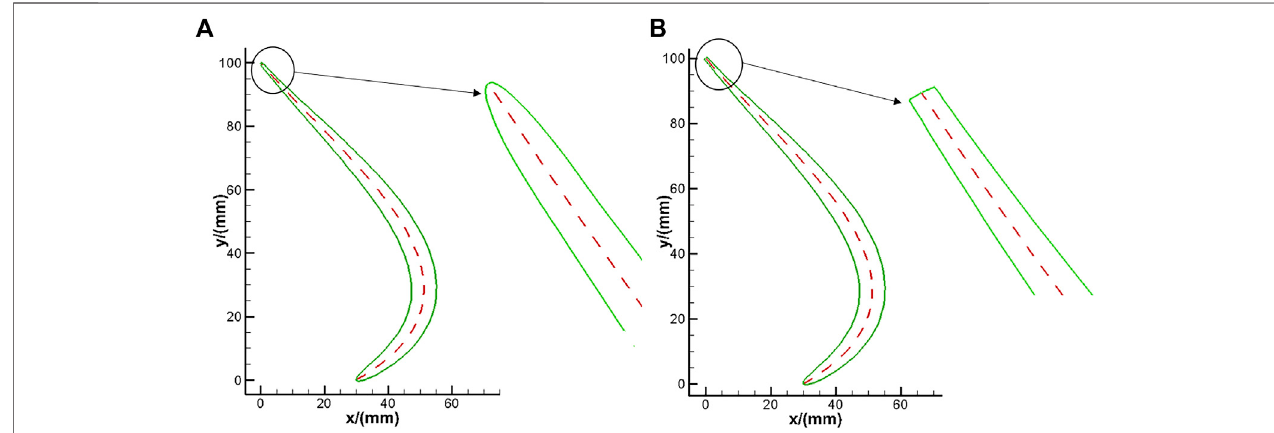
FIGURE 4 | The unequal thickness blade generated by the thickness distribution law of the round head. (A) round head (B) blunt head.